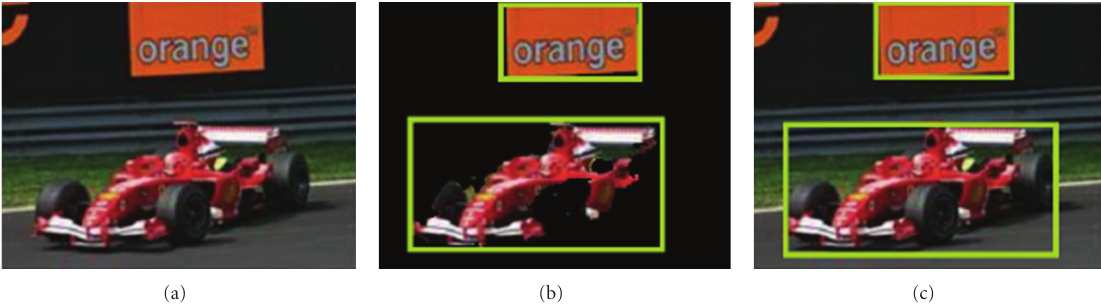
Figure 6: Examples of salient object detection: input image (a), detected salient objects (b), and ground truth salient objects (c).